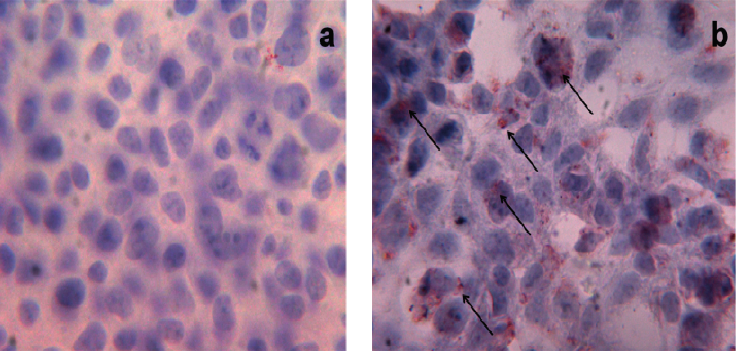
Figure 2. Triglyceride storage in HEK293 cells. Oil Red O staining of untreated ( a ) and treated ( b ) HEK293 cells with PA 1 mM. Red points indicate triglyceride depots; ×40